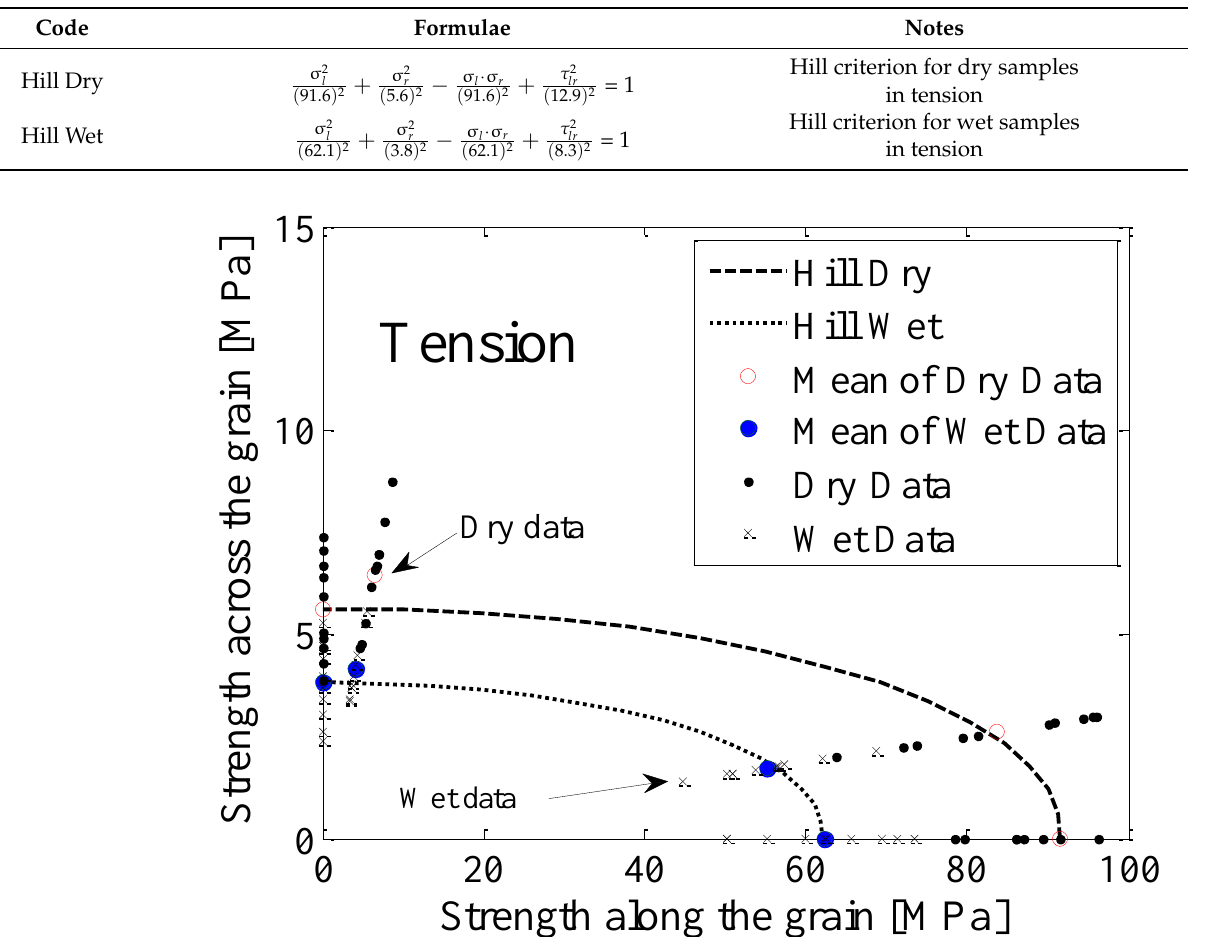
Figure 10. The tensile failure envelopes in the longitudinal and radial planes for E. nitens timber in dry ( MC = 12%) and wet ( MC > FSP ) states compared with the mean values of experimental data (the circles). The failure envelopes were determined based on Hill criteria [30] using the values of the parameters presented in Table 4.